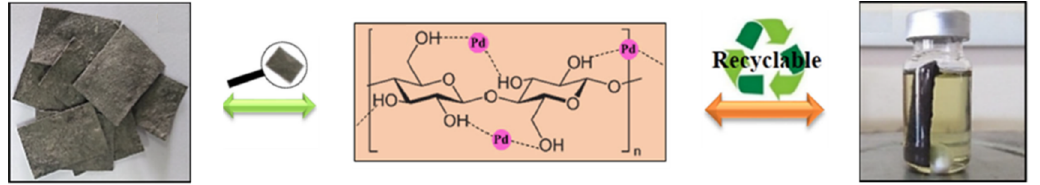
Figure 5. Dip catalyst as Pd(0)-loaded cellulose sheets; plausible structure of the Pd NPs-containing cellulose; typical experimental setup using the dip catalyst [58].